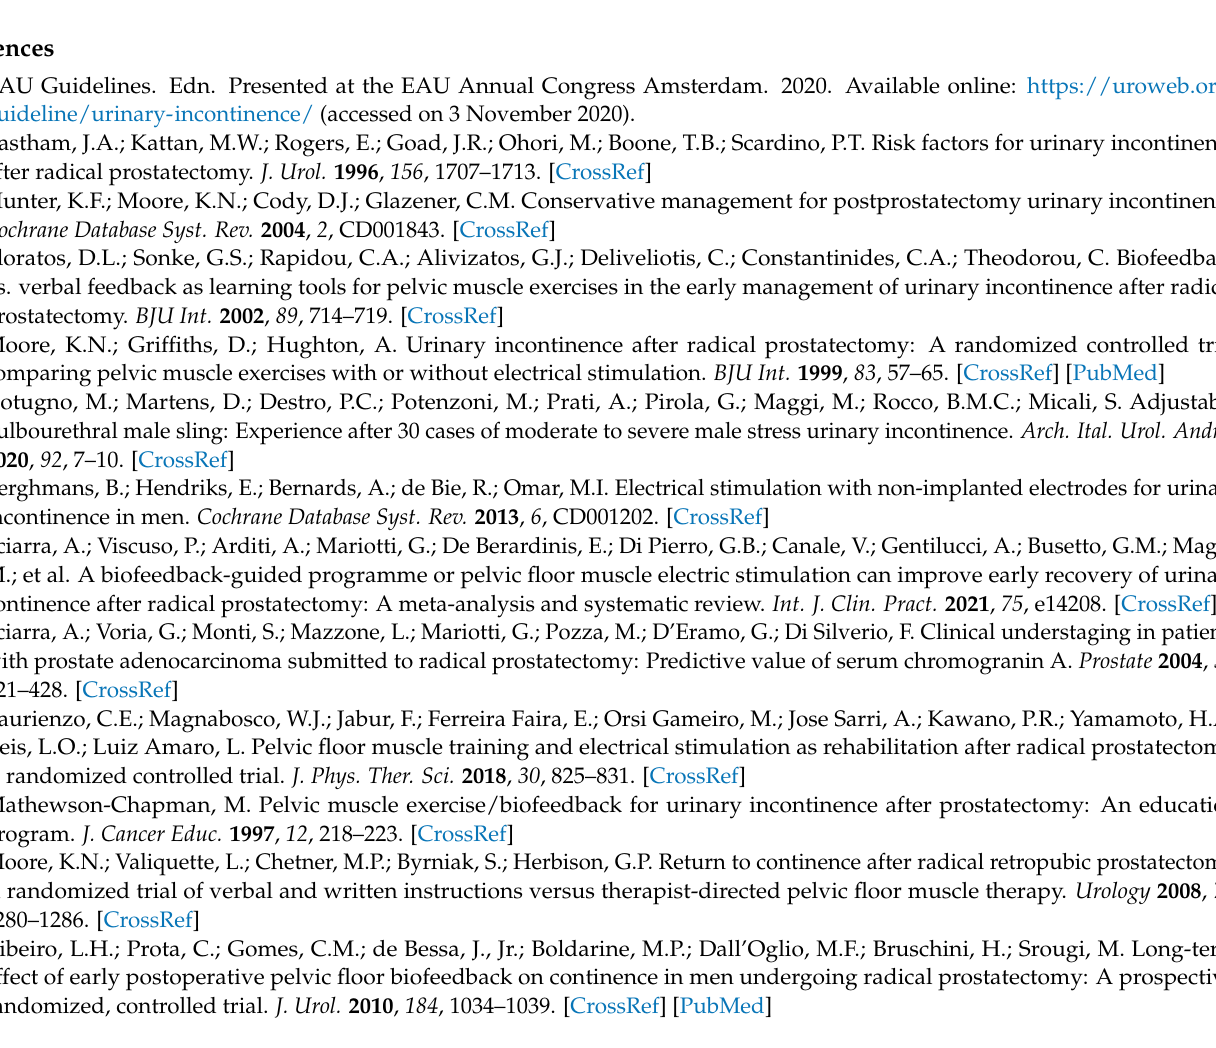
Supplementary Table S2. Comparison of characteristics of the population submitted to pelvic floor rehabilitation for urinary incontinence after radical prostatectomy on the basis of PAD free results at 3 -month interval (Mean ± SD, median. Number of cases (%). Two-tailed t test). Supplementary Figure S1. Prostate volume (PV) (cc) and baseline pad weight (g) mean values according to final pad-free status. 338 × 190mm (150 × 150